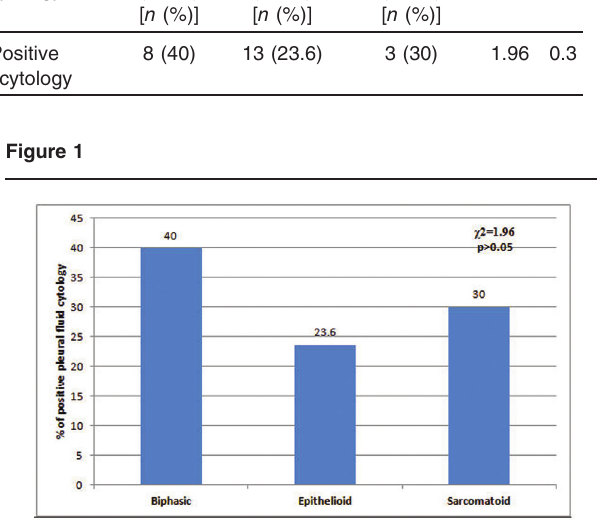
Relation between positive pleural fluid cytology and the type of mesothelioma.